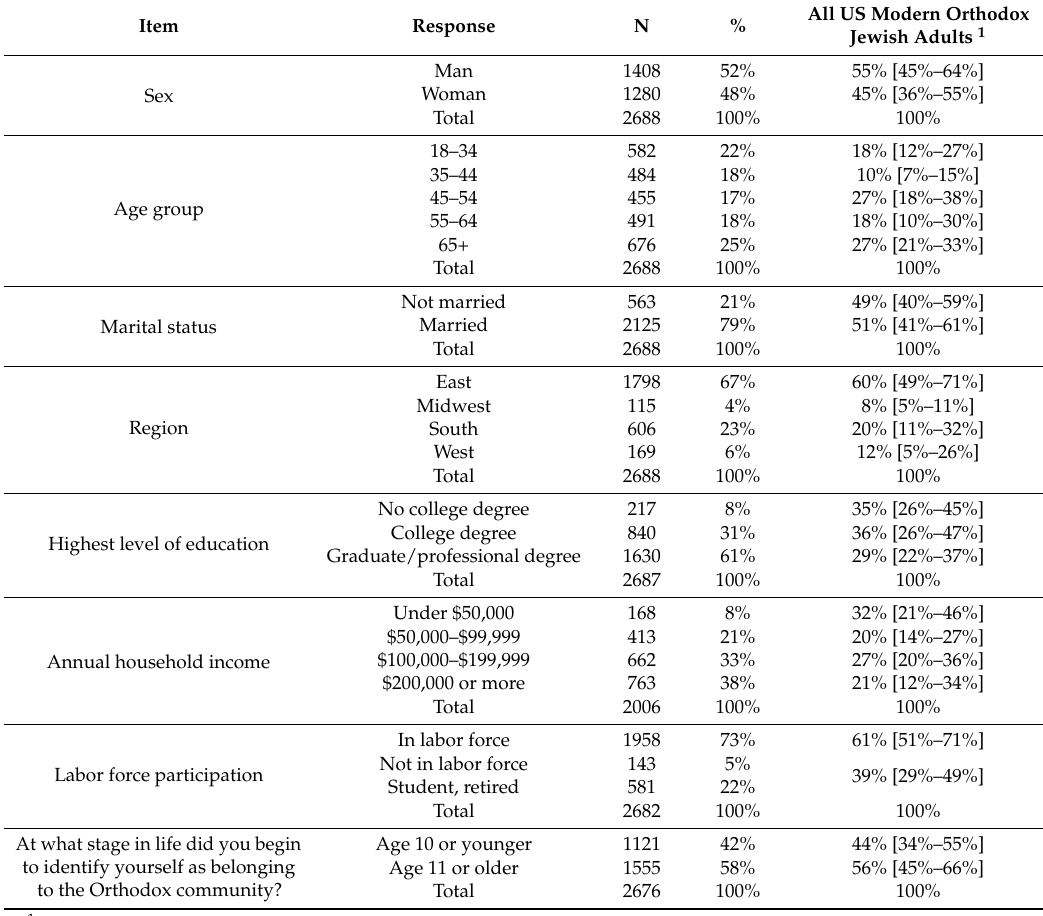
Table 1. Sociodemographic characteristics of